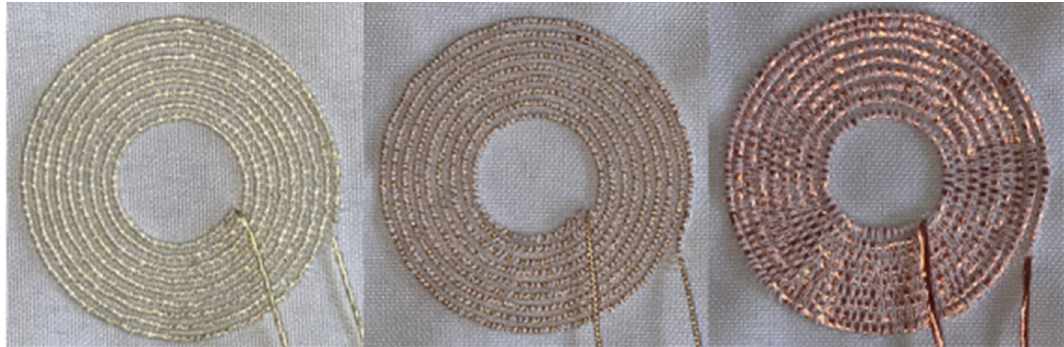
Figure 4. Embroidered coils with a diameter of 40 mm (from left to right) 40E12 ELITEX, 40U12 wrapping yarn, 40L12 copper wire.